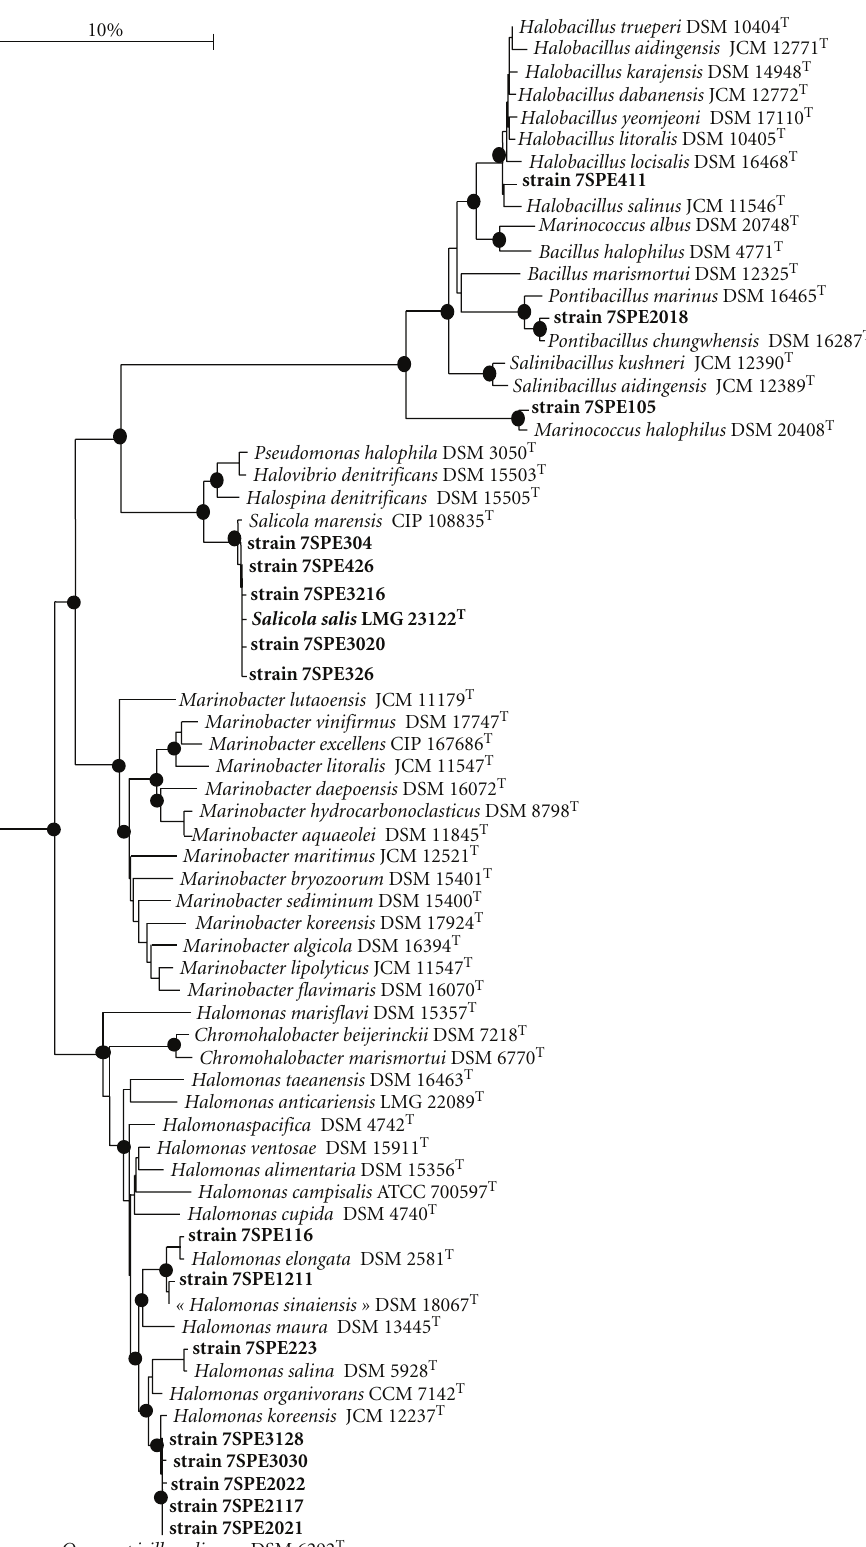
Figure 2: 16S rRNA gene-based phylogenetic tree of the bacterial domain, including 16S rDNA sequences from sediment samples from El-Djerid lake. Topologies of the phylogenetic tree built using maximum-likelihood and maximum-parsimony algorithms were similar to those of the tree constructed by neighbour-joining analysis. Solid circles indicate nodes with a bootstrap value higher than